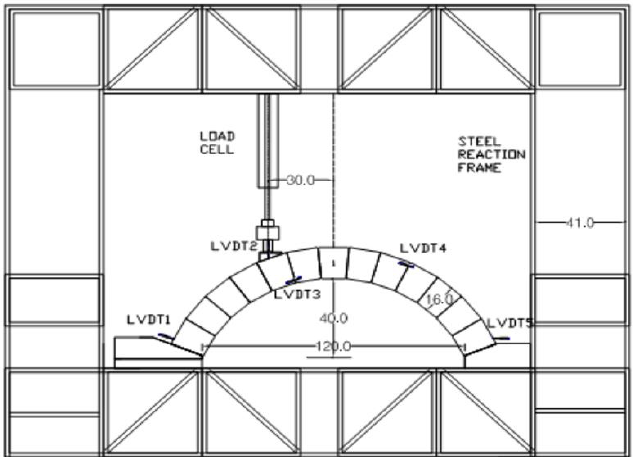
Figure 3. Quasistatic testing of a stone masonry arch (dimensions are in cm) [35].